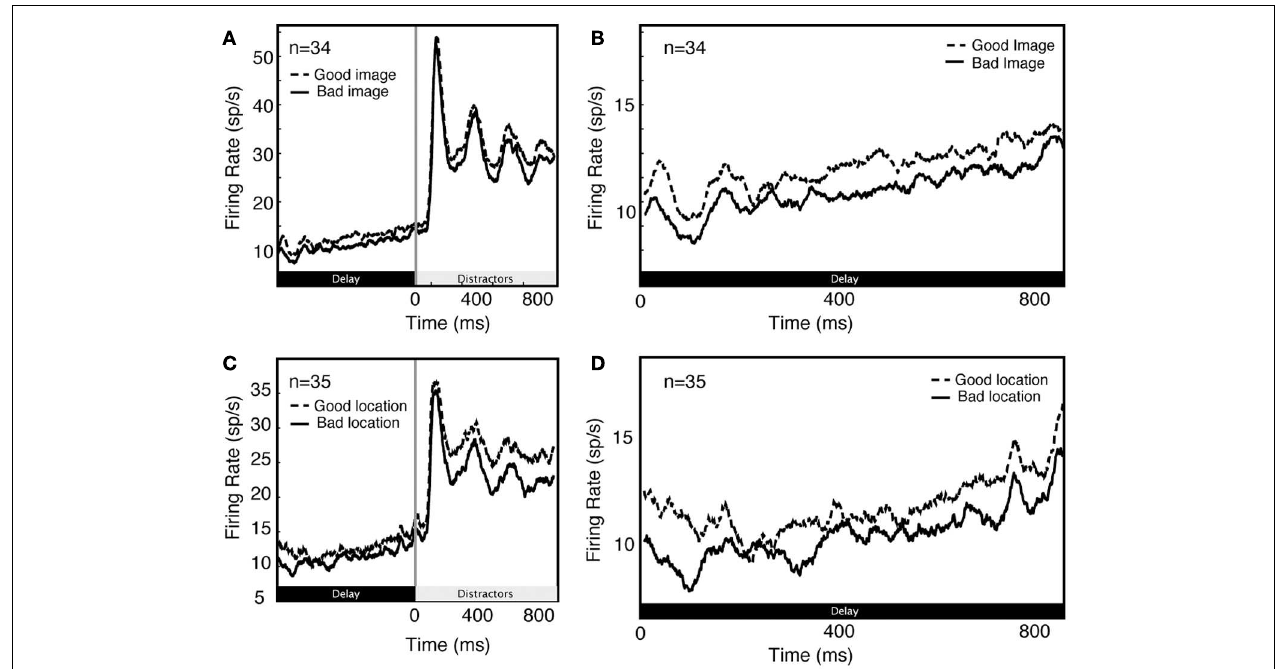
FIGURE 4 | Comparison of feature (A,B) and spatial (C,D) effects during early part of trial (A,C) and during delay period along (B,D).